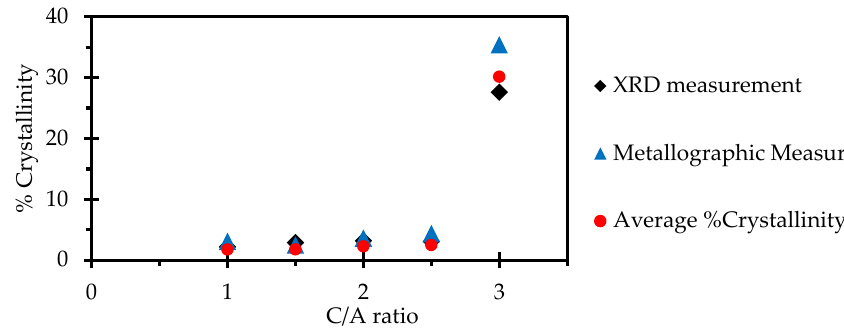
Figure 7. Cross sectional images of each C-series mould powders are illustrated in Figure 8. Figure 9. The crystallinity of C-series mould powders gradually increased by increasing the CaO/Al 2 O 3 ratio from 1 to 2.5, while a sudden increase in crystallization was observed when the ratio was increased from 2.5 to 3.